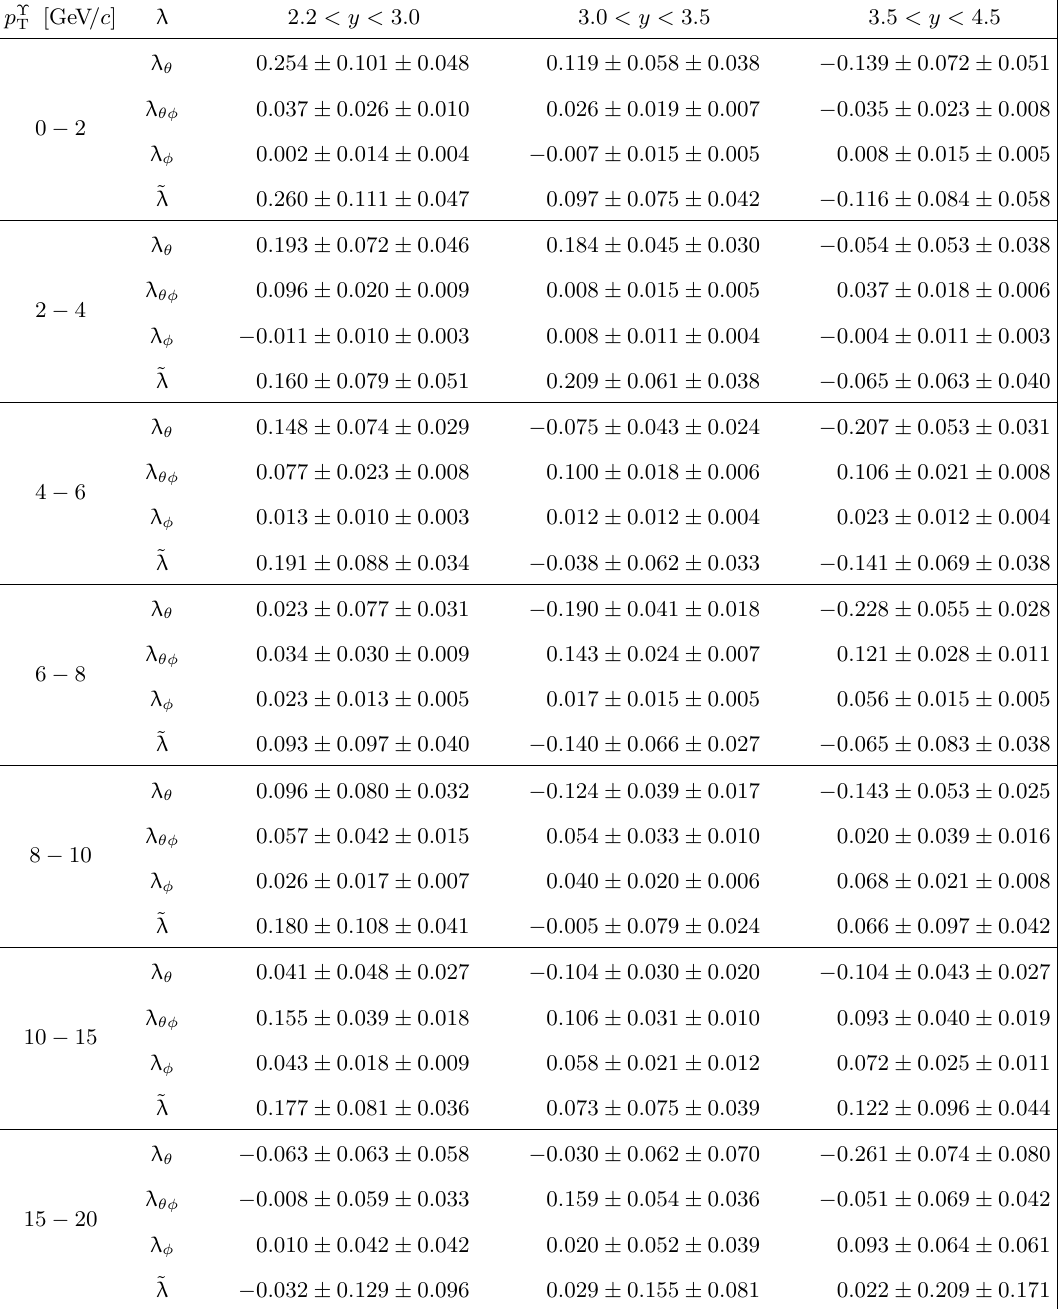
Table 14 . Values of (cid:21) (cid:18) , (cid:21) (cid:18)(cid:30) , (cid:21) (cid:30) and ~ (cid:21) measured in the CS frame for the (cid:7)(2S) produced at p s = 8 TeV. The (cid:12)rst uncertainty is statistical and the second systematic.